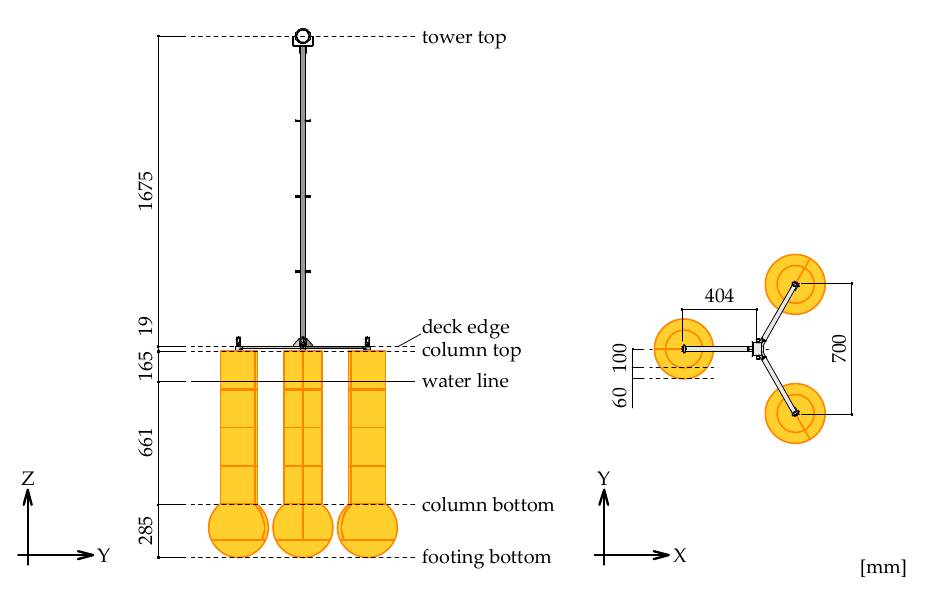
Figure 1. Main dimensions of the reduced scale model.